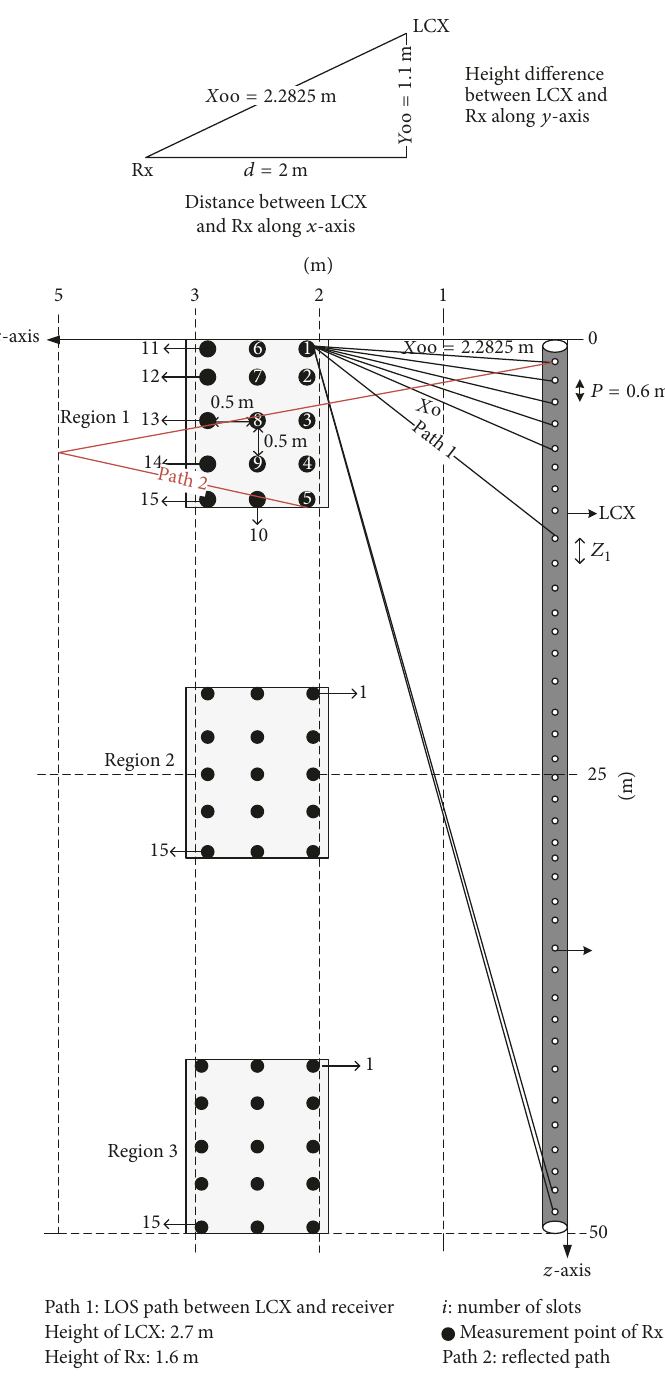
Figure 4: The visualization of Nantong Tunnel